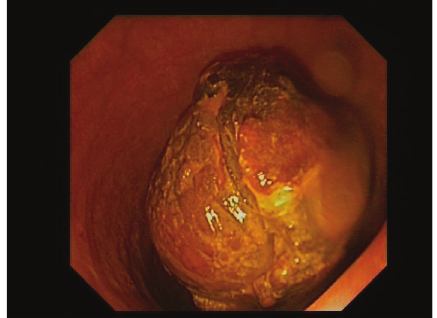
Figure 3: Endoscopy image big gallstone.